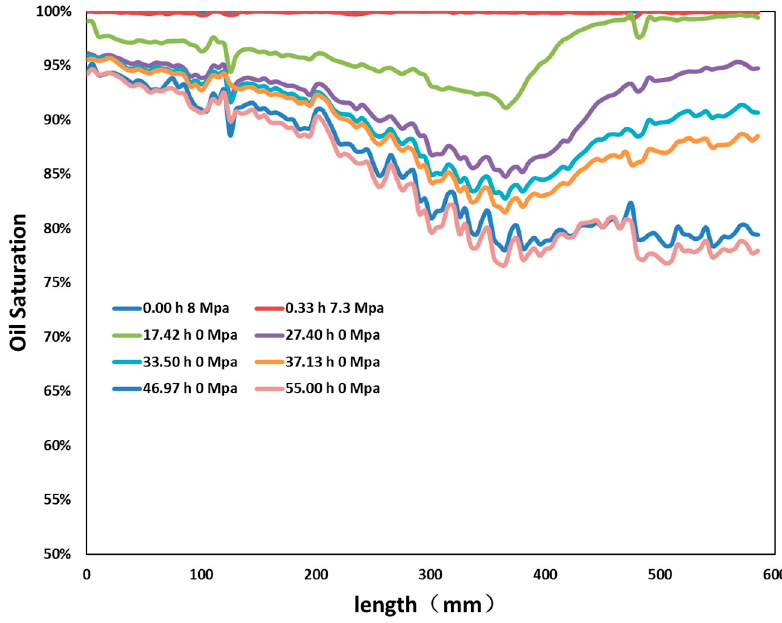
Figure 8. Oil saturation distribution curves in Experiment 3.